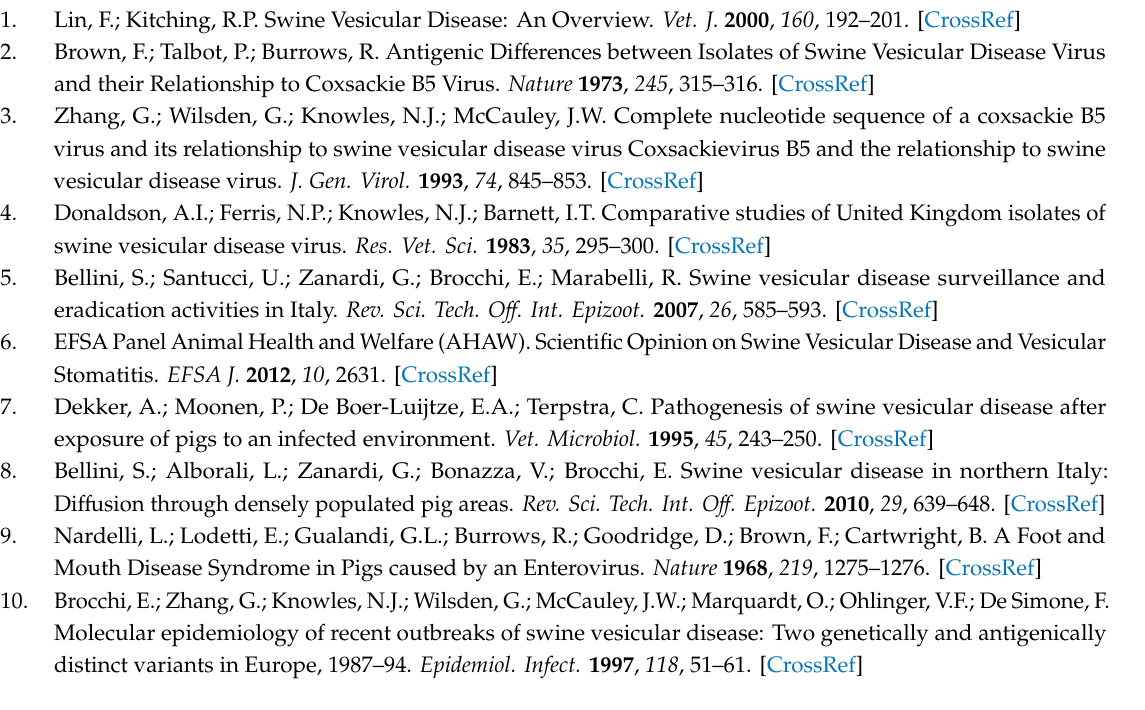
Table S1: Designation and origin of SVDV, porcine teschoviruses (PTV), and porcine enteroviruses (PEV) studied. Figure S1. Alignment of SVDV-3D sequences (including the nucleotide region 6870–7083 according to the reference strain UKG 27 / 72 (X54521.1)) showing mismatches for the 14 samples belonging to the sub-lineage 1 undetected in RT-LAMP. Figure S2. Alignment of SVDV-5 (cid:48) UTR sequences (including the nucleotide region 252–332 according to the reference strain UKG 27 / 72 (X54521.1)) showing mismatches for the six samples belonging to sub-lineage 1 undetected in 2B-IR rtRT-PCR. Figure S3. Alignment of SVDV-5 (cid:48) UTR sequences (including nucleotide region 455–522 according to the reference strain UKG 27 / 72 (X54521.1)) showing mismatches found in a representative selection of seven samples belonging to sub-lineage 1 and two samples belonging to sub-lineage 2 (*) undetected in the 3-IR real-time